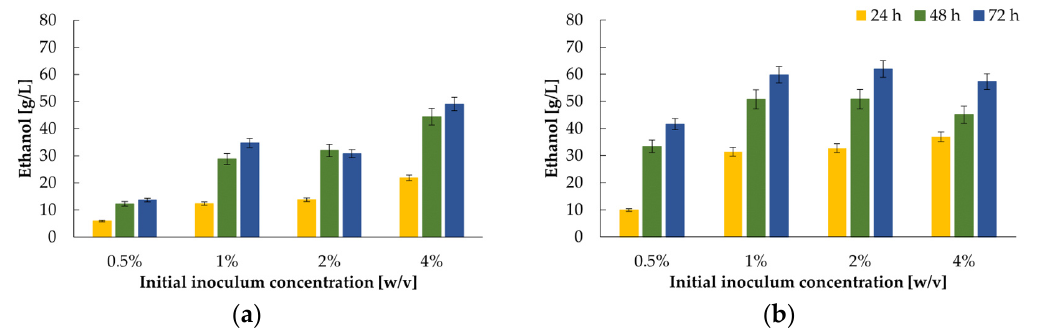
Figure 6. Ethanol production during 72 h batch cultures in 200WP medium with: ( a ) freeze-dried biomass; ( b ) preincubated for 4 h at 30 °C in SAB medium freeze-dried biomass of K. marxianus WUT240.